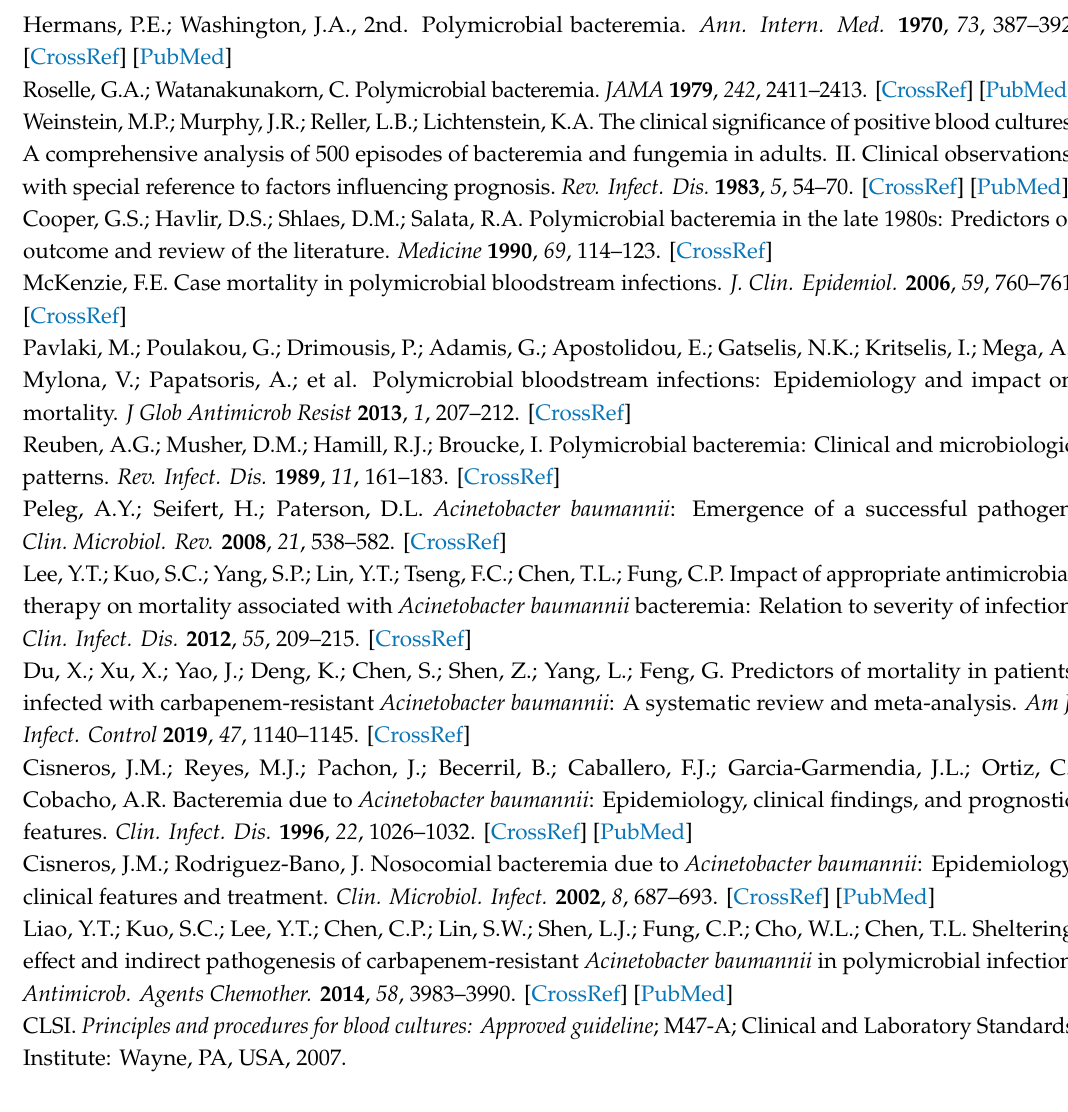
cocci. Figure S2: Kaplan–Meier plot showing the survival rates of patients with acquired polymicrobial multidrug-resistant Acinetobacter baumannii (MDRAb) bacteremia with concomitant Gram-negative bacilli (GNB), polymicrobial Ab bacteremia with concomitant Gram-positive cocci (GPC), and those with acquired monomicrobial MDRAb